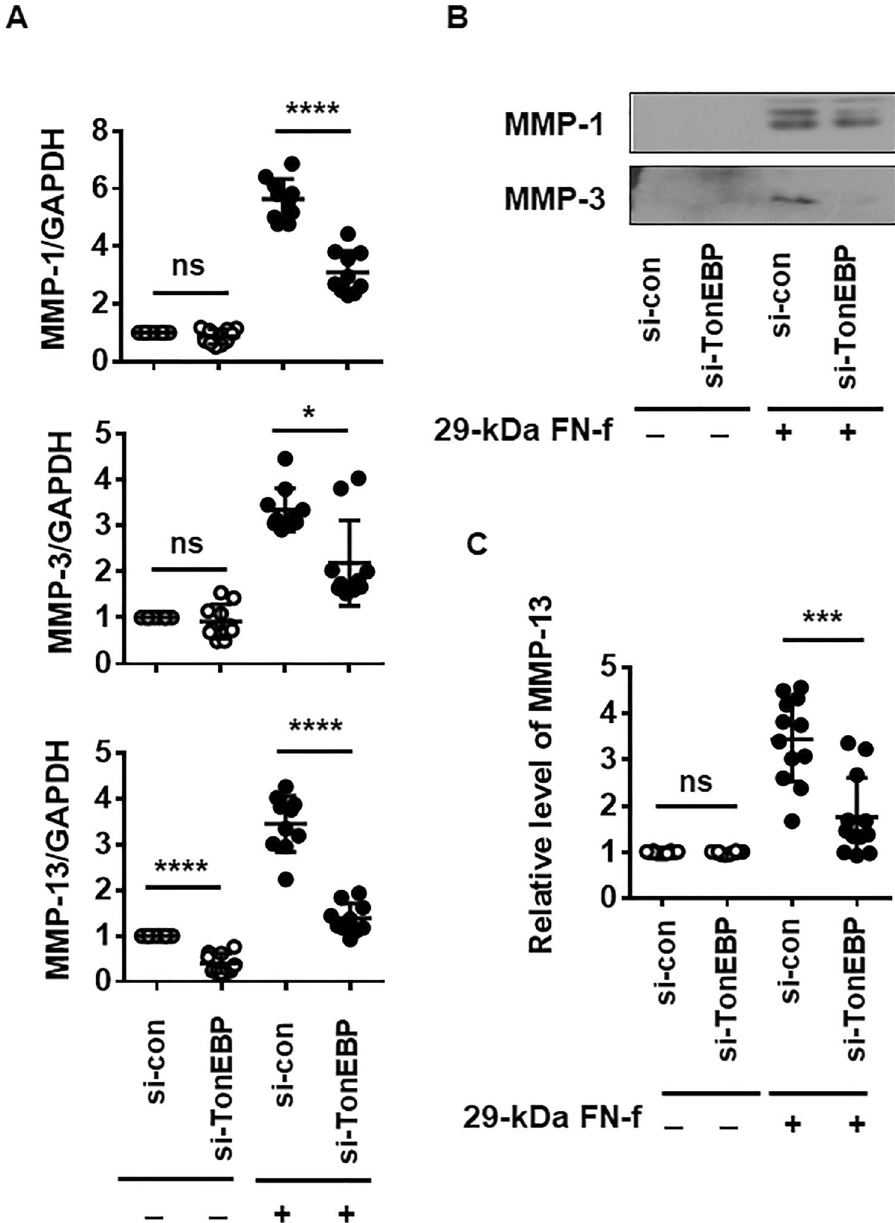
Figure 2. TonEBP regulates 29-kDa FN-f-dependent expression of MMPs. Knockdown of TonEBP suppressed MMP expression induced by 29-kDa FN-f at both the ( A ) mRNA and ( B , C ) protein levels. Chondrocytes were transfected with si-TonEBP. After 48 h, cells were stimulated with 29-kDa FN-f (300 nM) for ( A ) 6 h and ( B , C ) 24 h. mRNA levels of MMPs 1, 3, and 13 were measured by QuantiFast SYBR Green qRT-PCR. Data are expressed as the mean ± SD of duplicate data from five independent donors. * P < 0.05 and **** P < 0.0001 vs. si-con-treated control; ns, not significant. ( B ) Protein expression of MMPs 1 and 3 from chondrocyte culture medium were measured by western blot analysis. ( C ) MMP-13 protein expression was measured by ELISA. Culture medium from 29-kDa FN-f-treated and untreated cells was incubated in a round-bottom microplate for 14 h, and then an antibody against MMP-13 was added to each well followed by further incubation for 14 h. Data are expressed as the mean ± SD of triplicate data from four independent donors. *** P < 0.001 vs. si-con- treated control; ns, not significant. ( A , C ) The figures were analyzed and produced by GraphPad Prism software (GraphPad Prism 6.07; https:// www. graph pad. com/ scien tific- softw are/